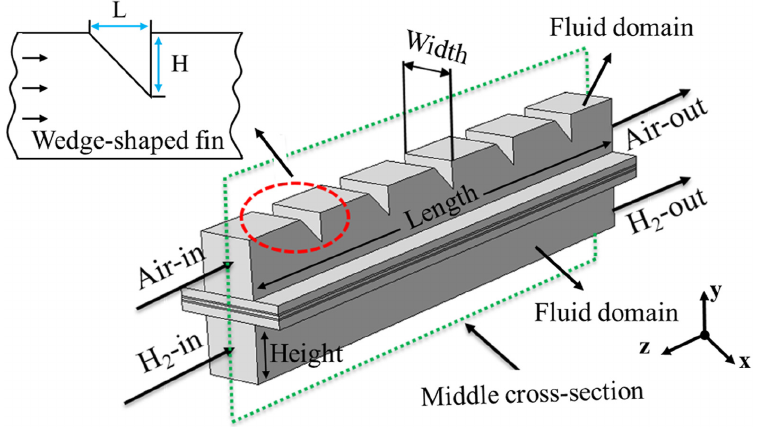
Figure 20. The physical model of PEMFC with wedge-shaped fins